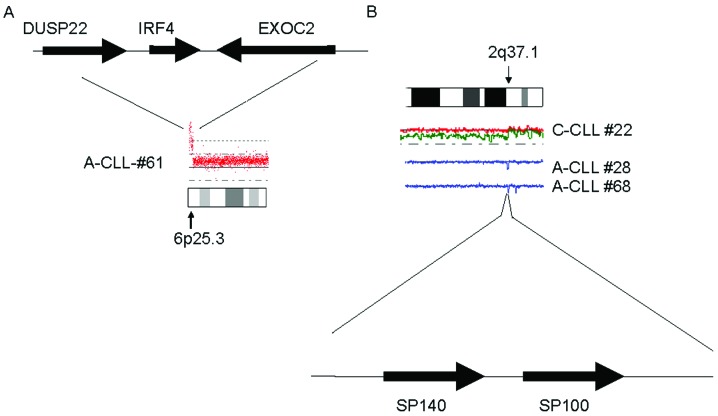
Genes close to high-risk SNP sites are targets for genomic alterations in CLL. (A) CLL with amplification of IRF4. The result of SNP-chip analysis (orange dots) is shown with the scheme of the chromosome (bottom) and genes (top). An arrow on the chromosome panel shows the position of the 6p25.3 involving the IRF4 gene. Arrows on the top panel indicate the direction of transcription of the genes. The case number is shown on the left side (A, Asian). (B) CLL cases with deletion of SP140. The result of SNP-chip analysis (blue lines or red/green lines) is shown with the scheme of the chromosome (top). An arrow on the chromosome panel indicates the position of 2q37.1 involving SP140. Arrows and their diagonal lines at the bottom indicate the direction of transcription and location of SP100/SP140 genes. The case numbers are shown on the right side (A, Asian; C, Caucasian).